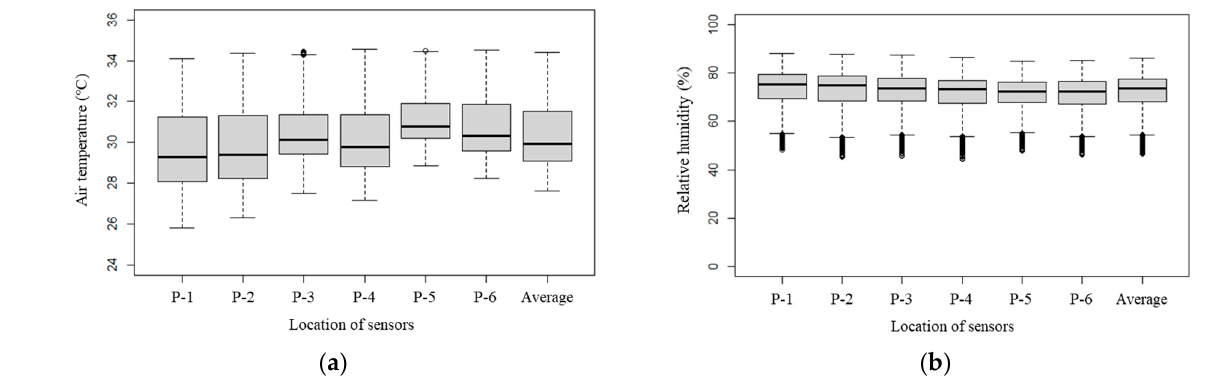
Figure 7. A box plot with the 1.5 IQR (Interquartile range) of the measured environments inside the fattening pig house. ( a ) Air temperature. ( b ) Relative humidity.